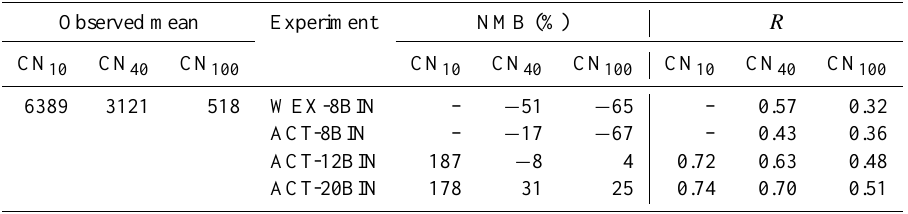
Table 8. Same as Table 7, except for the T1